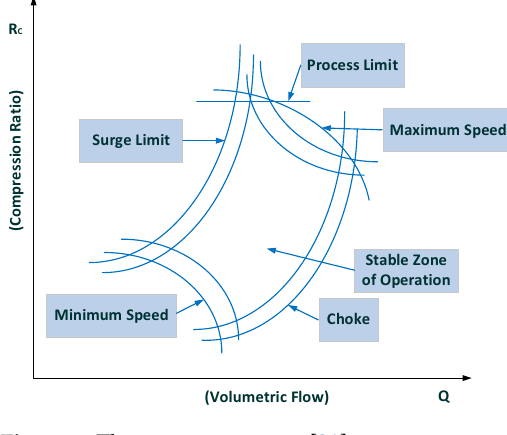
Figure 8. The compressor map [21].